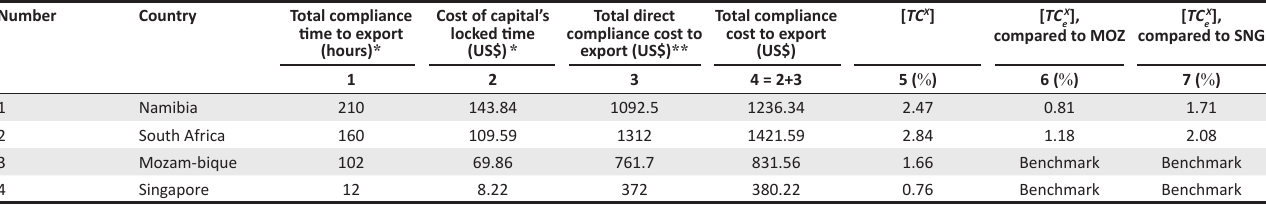
TABLE 5: Total compliance time and cost to export (2018) and estimated rate of excess cost compared to benchmark